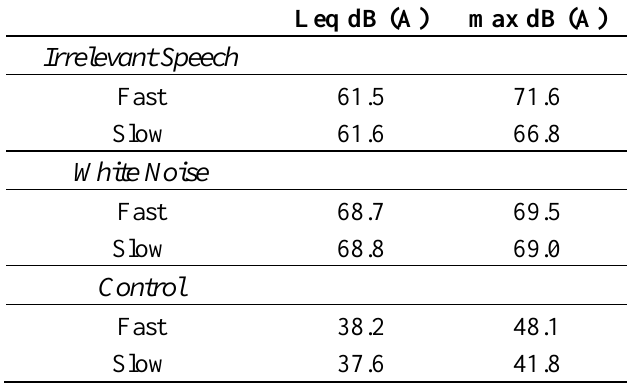
Table 1. Measures of the SPLs for noise conditions and control